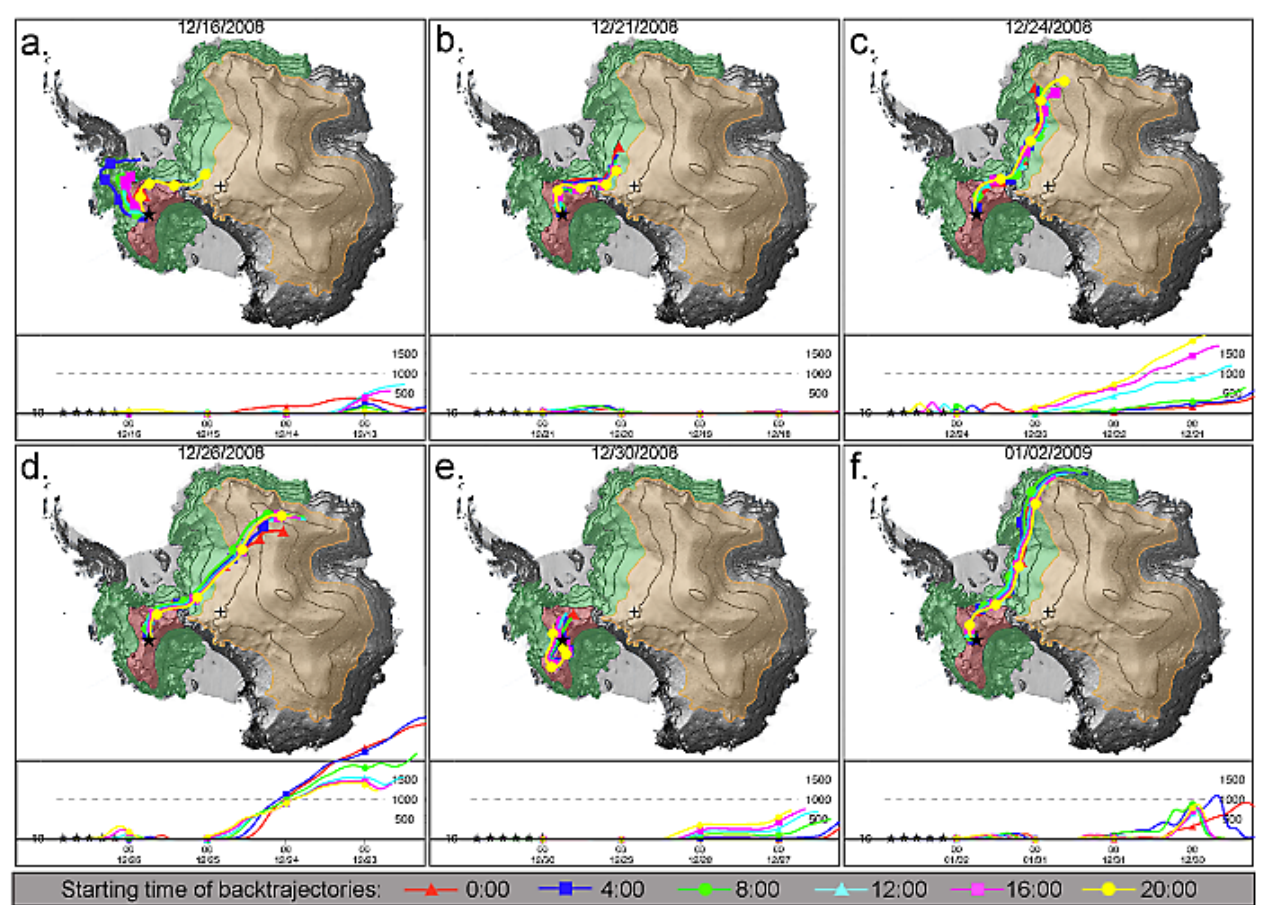
Fig. 10. Combined 4-day back-trajectory maps of some specific events identified in Fig. 11. Each daily map contains 6 trajectories of 4-hour intervals and symbols are plotted for every 24h time step. The different regions of air origin are identified in Fig. 9. Trajectory colors do not correspond to map colors. Trajectory elevations are meters above ground